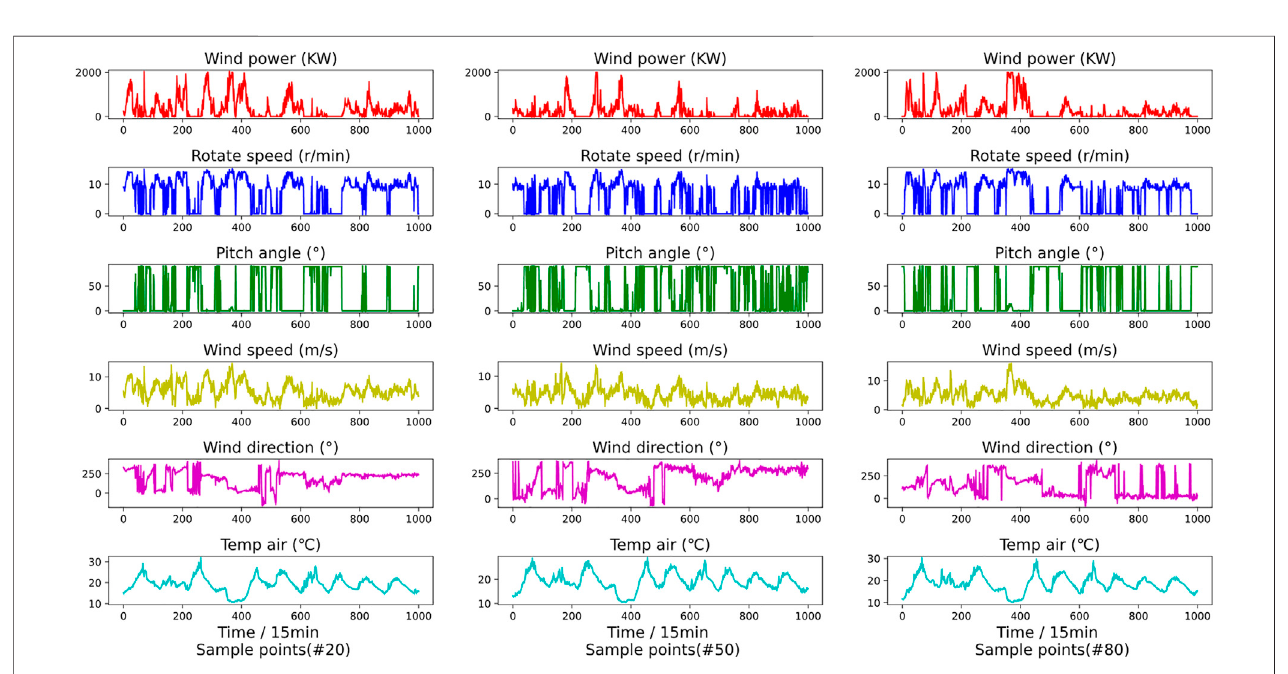
FIGURE 3 | Partial sampling data display of wind turbines #20, #50, and